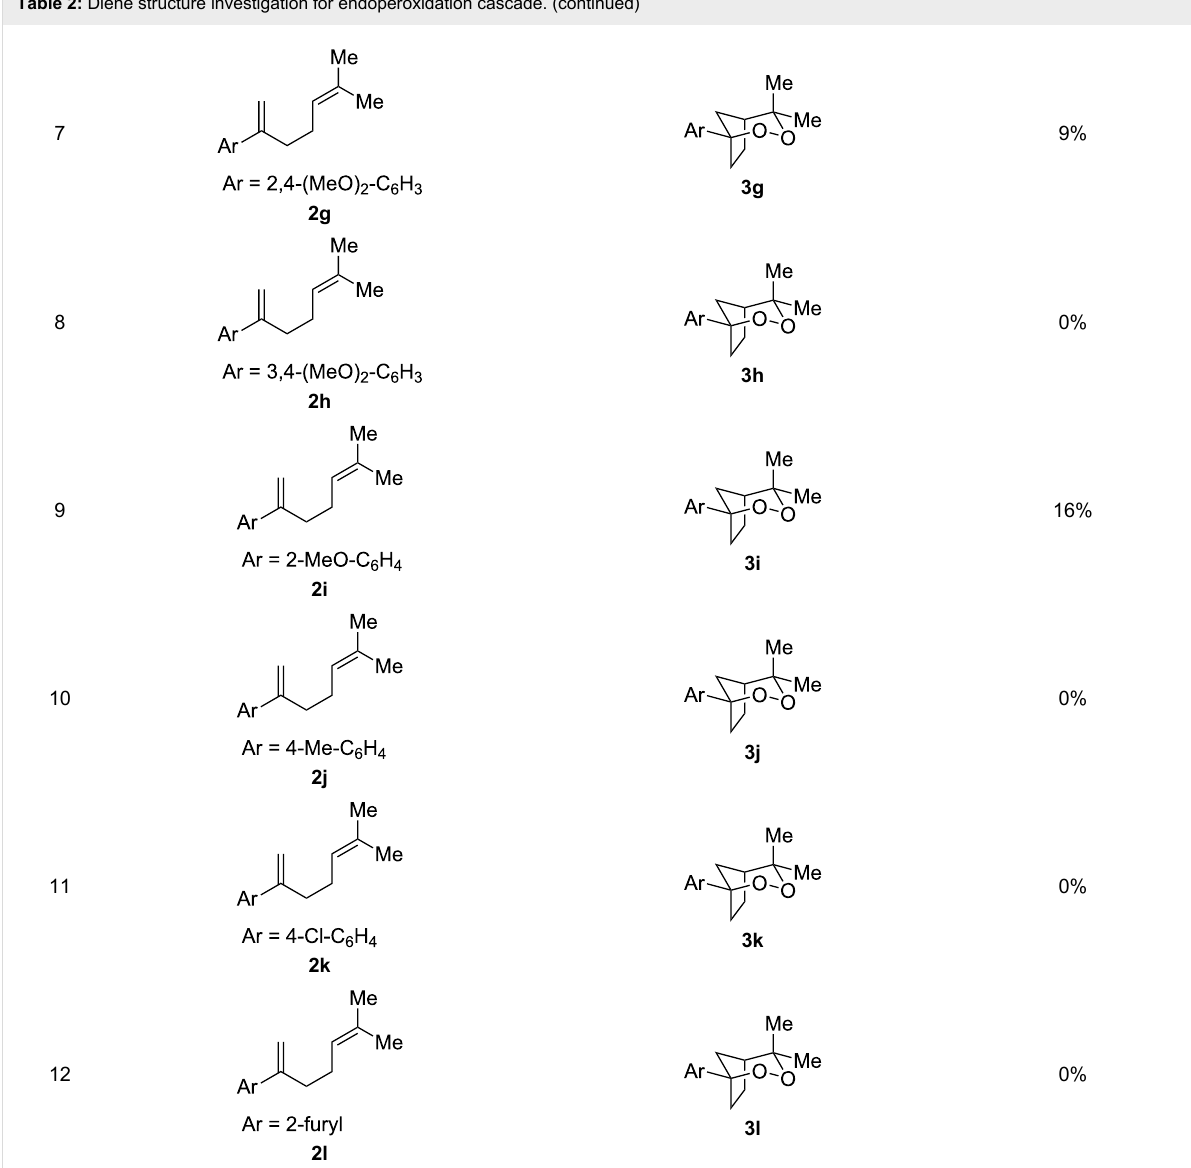
Table 2: Diene structure investigation for endoperoxidation cascade.